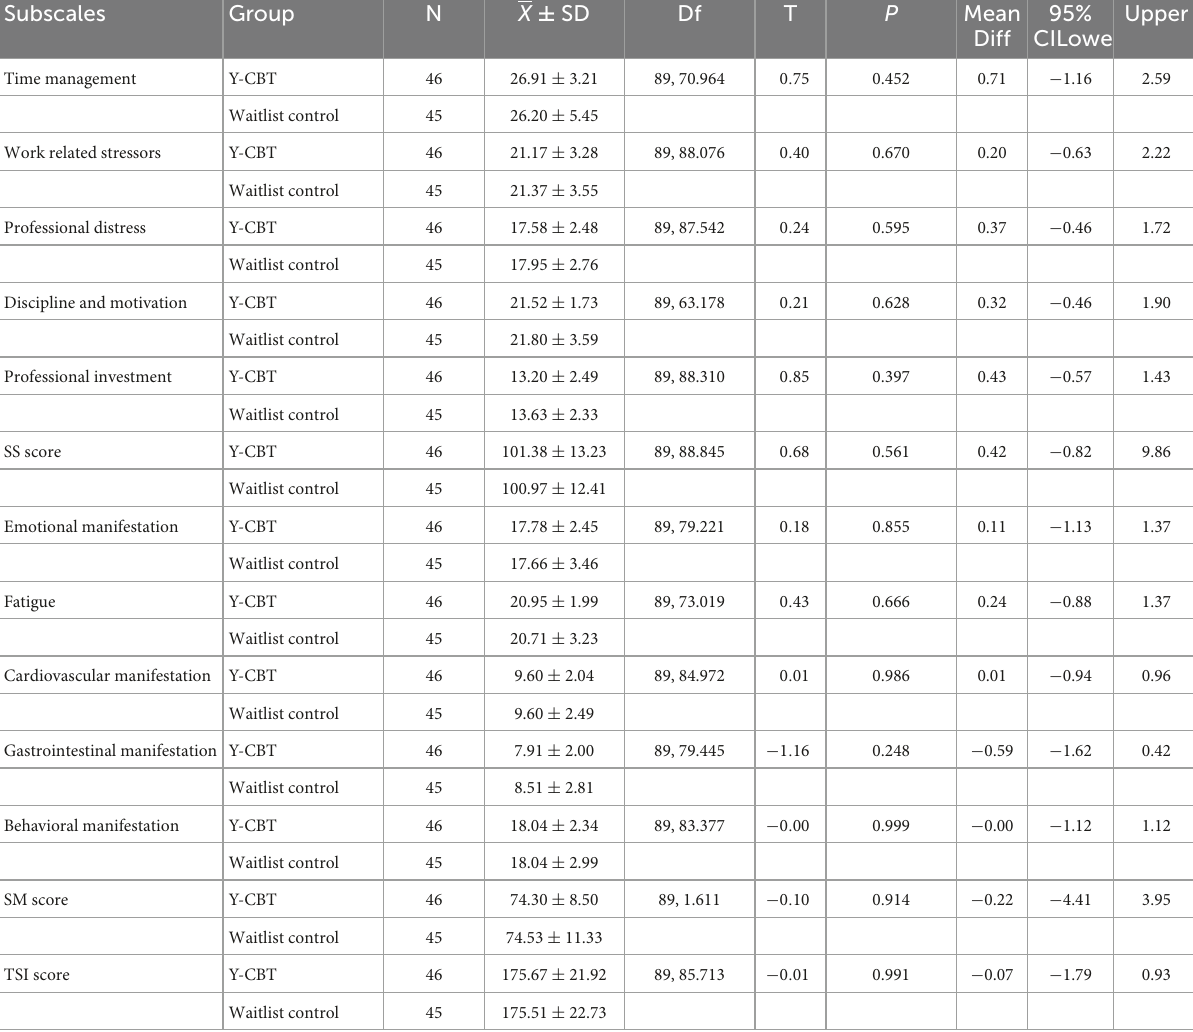
TABLE 2 T -test analysis of the baseline data on teachers’ stress inventory subscales.